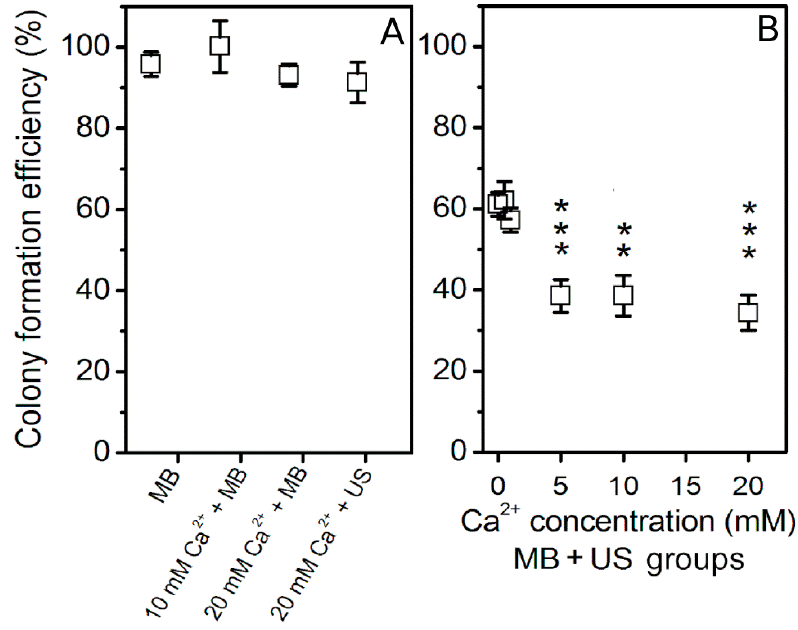
Figure 4. Cell colony formation efficiency, evaluated after cell treatment with US (400 kPa) in the presence of MBs at different Ca 2+ concentration. (MB), (Ca 2+ + MB) and (Ca 2+ + US) experimental groups ( A ); (Ca 2+ + MB + US) experimental groups ( B ). ** p < 0.01, *** p < 0.001 indicate statistical significance between cavitation [(Ca 2+ + MB +US) at 0 mM Ca 2+ concentration] and therapeutic [(Ca 2+ + MB +US) at 1–20 mM Ca 2+ concentration] groups.